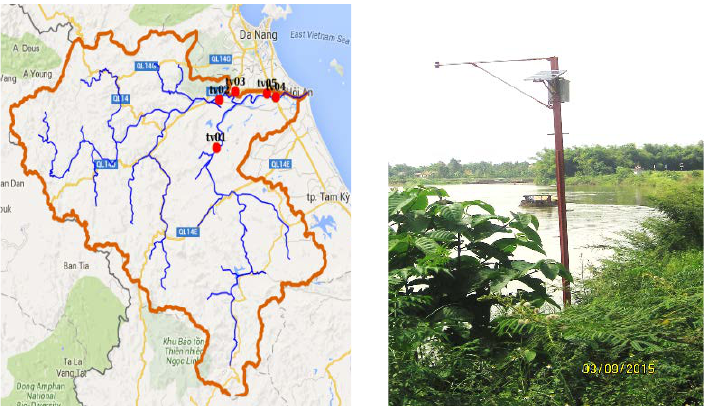
Figure 13. Location ( left ) and sample picture ( right ) of meteorological stations in the Vu Gia-Thu Bon river basin.